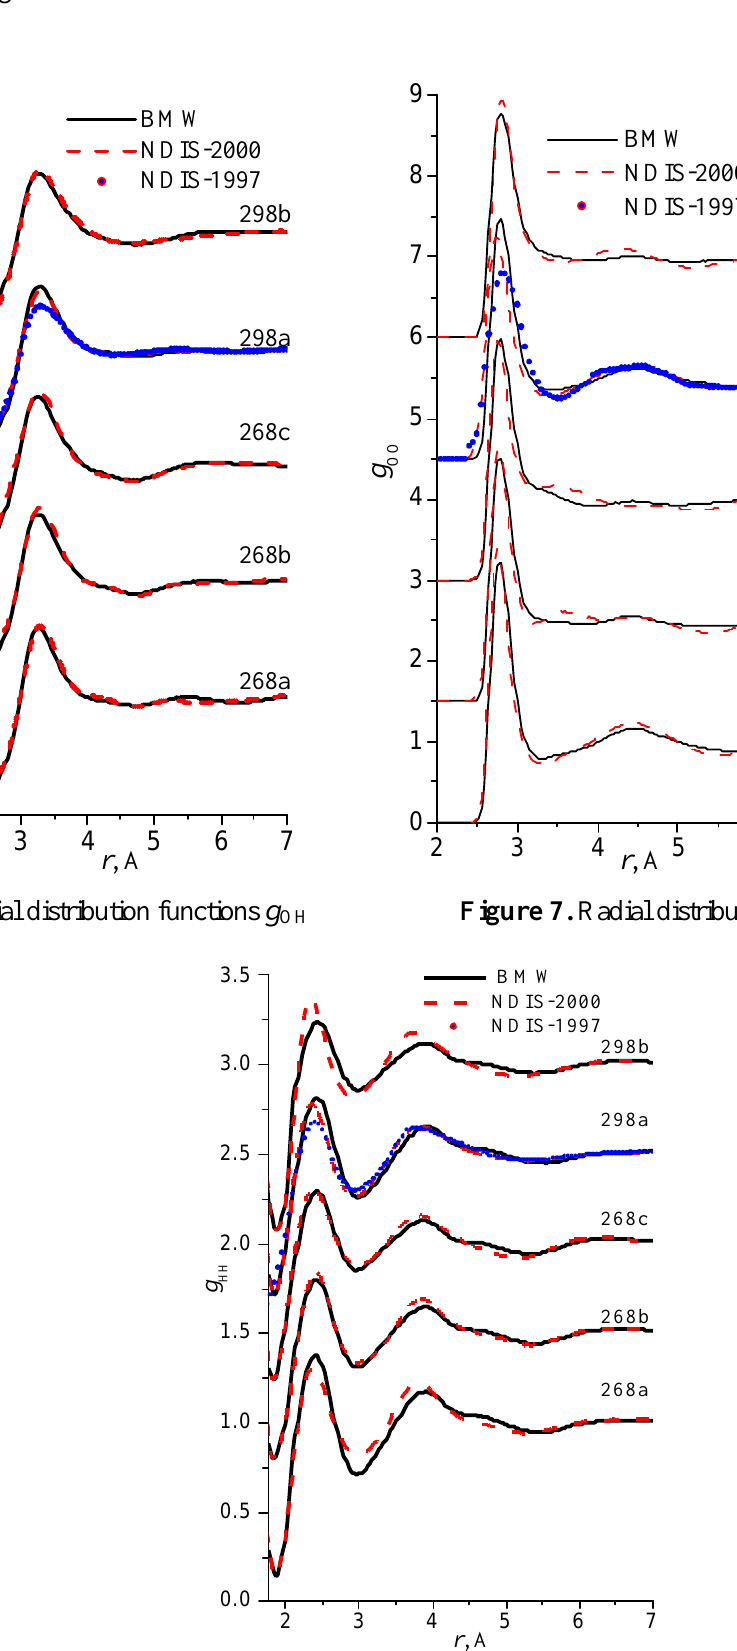
Figure 8. Radial distribution functions g